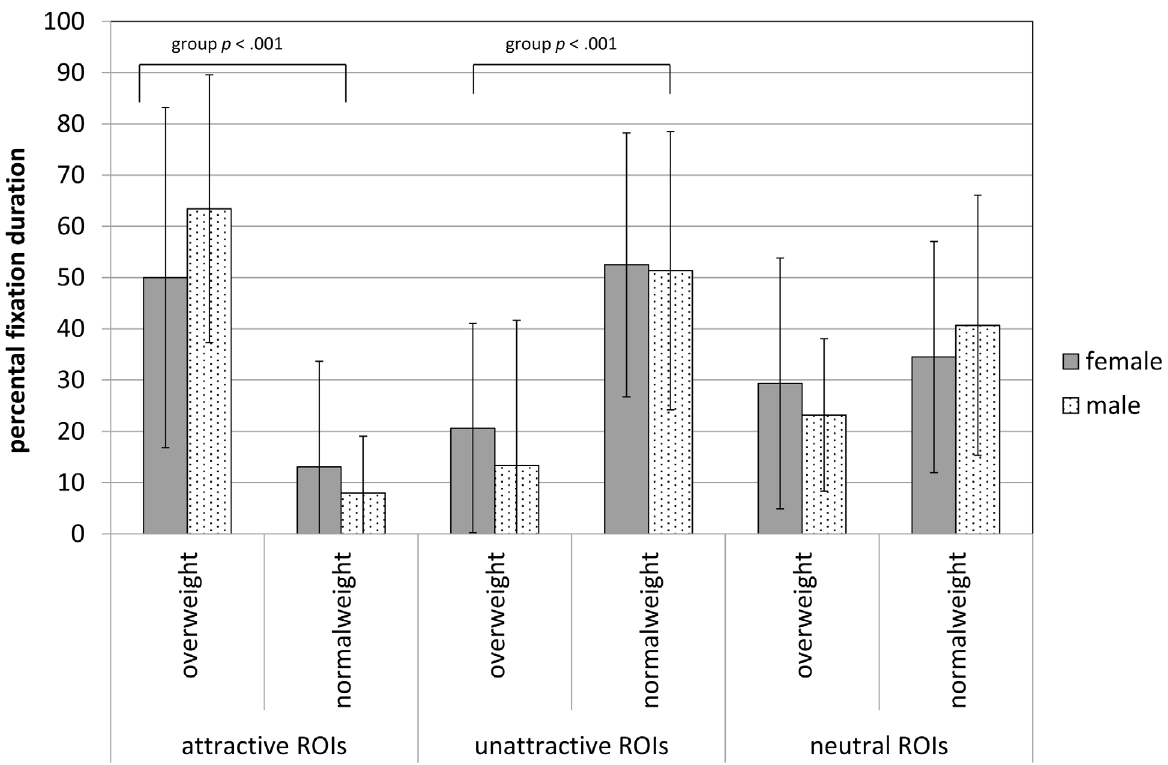
Fig 3. Percentage of dwell time for the control body (mean, standard deviation) for attractive, unattractive and neutral ROIs. Displayed are p -values of between-subjects analysis, following significant multivariate analysis (group F (2, 50) = 20.27, p < .001, η 2 = .448), gender ( F (2, 50) = 0.18, p = .837, η 2 = .007), interaction ( F 2, 50) = 1.21, p = .306, η 2 = .046), covariate age F (2, 50) = 2.03, p = .142, η 2 = .075).